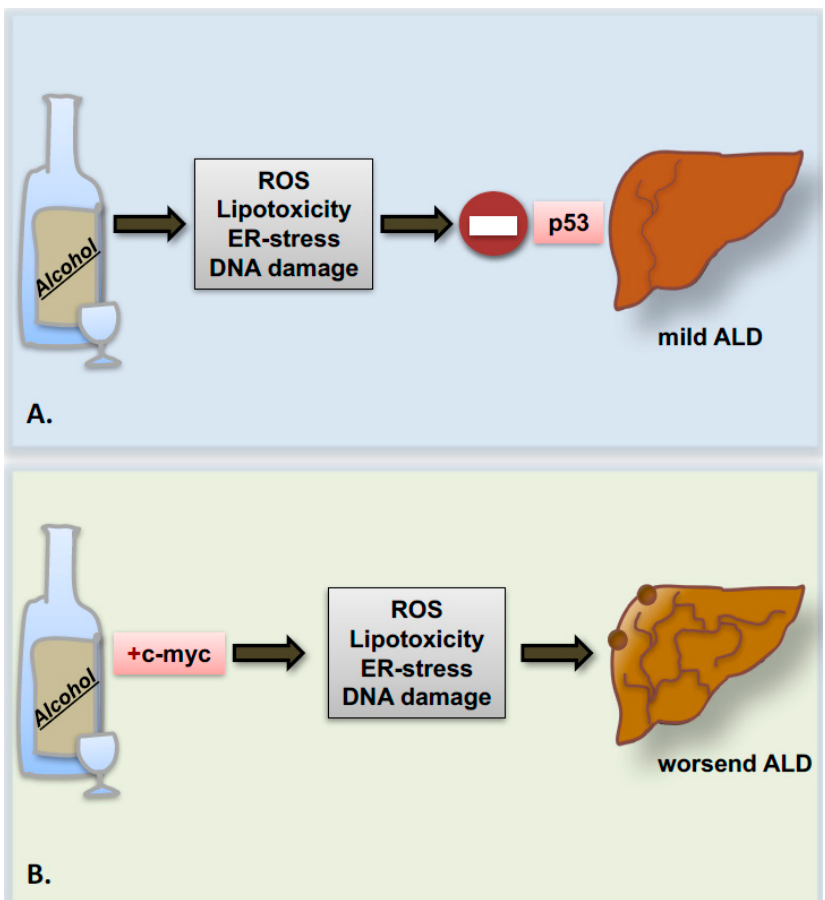
Figure 3. Enhanced expression of c-myc in liver promotes ALD progression. ( A ) Ethanol consumption leads to liver injury by generating ROS, lipid peroxidation, ER-stress and DNA-damage reactions: an effect buffered by “guardian” function of p53. ( B ) Alcohol intake and concomitant c-myc overexpression abrogate p53 activation and cause ALD progression to advanced precancerous stages.